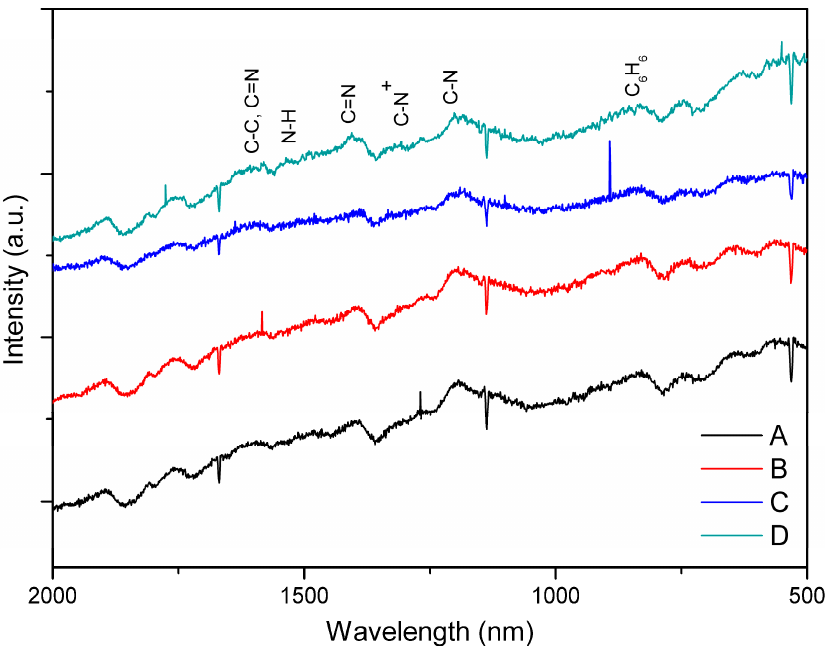
Figure 1. Raman spectra of polyaniline (PAni) powders polymerized under constant aniline (An) concentration (5.48 M) and different concentrations of acid dopants: ( A ) 0.1 M HCl; ( B ) 0.1 M CH 3 COOH; ( C ) 0.01 M HCl; and ( D ) 0.01 M CH 3 COOH. a.u.: Arbitrary units.